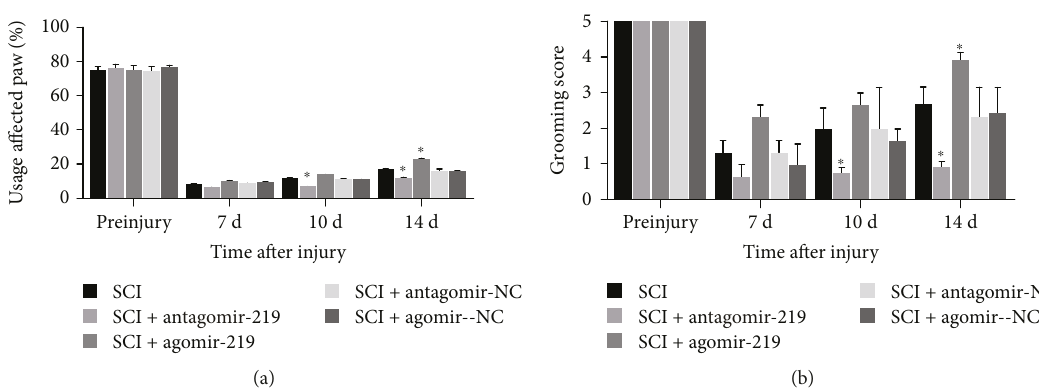
Figure 5: E ff ect of miR-219 on forelimb movement during behavioral tests after C5 hemicontusion. (a) Compared to preinjury, the rats in the SCI group produced marked de fi cits in rearing performance on days 7, 10, and 14 after SCI ( p < 0 001 ). Rats on days 10 and 14 after SCI in the antagomir-219 group exhibited a more profound decline in usage of the a ff ected paw, whereas a signi fi cant increase on day 14 after SCI was observed in the agomir-219 group. (b) A more severe grooming de fi cit of the ipsilateral paw was observed after contusion injury ( p < 0 001 ). At days 10 and 14 postinjury, animals in the antagomir-219 group achieved lower scores than did those in the SCI group, whereas only on day 14 postinjury the rats in the agomir-219 group achieved higher scores than did the SCI group. Error bars indicate SEM. ∗ p < 0 05 . NC: negative